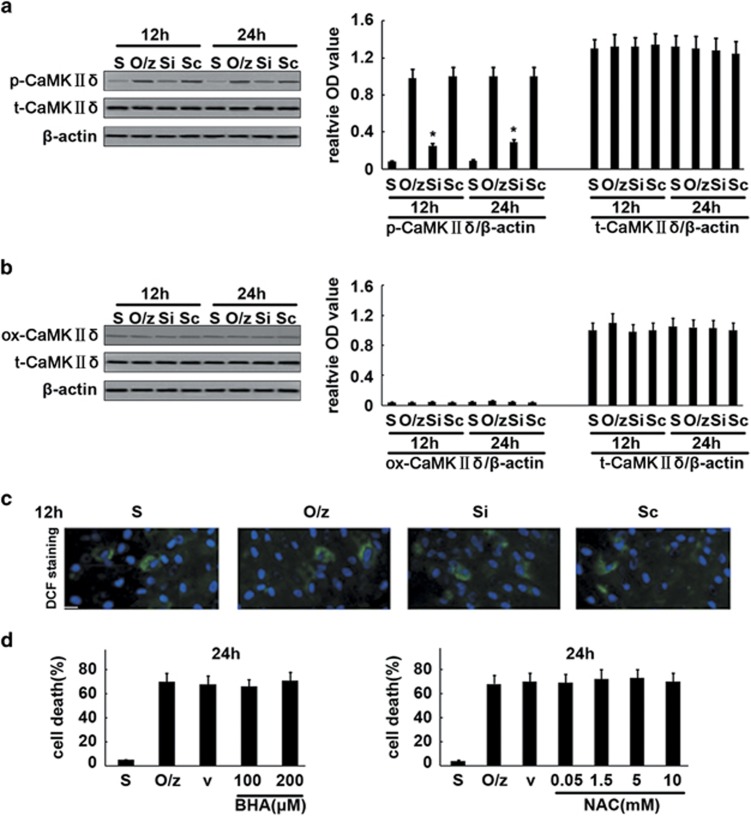
CaMKIIδ is activated via phosphorylation, but not oxidation, in OPCs after OGD/zVAD insult. (a) Representative western blotting images and averaged data indicating phosphorylated and total CaMKIIδ levels in OPCs. Phospho-Thr287 CaMKIIδ levels were increased in OPCs in the OGD/zVAD group 12 and 24 h after OGD, whereas total CaMKIIδ was not affected. Furthermore, RIPK3 inhibition via siRNA decreased phospho-Thr287 CaMKIIδ levels 12 and 24 h after OGD. Data are presented as means ±S.E.M. from three independent experiments. N=6 for each group in each experiment (P<0.05, comparing the siRNA group with the OGD/zVAD group). S: sham; O/z: OGD/zVAD; Si: RIPK3 siRNA; Sc: RIPK3 siRNA scramble. (b) Representative western blotting images and averaged data for oxidation of CaMKIIδ (ox-CaMKII) at M281/282. In the sham control group, CaMKIIδ oxidation is very weak. OGD/zVAD insult did not enhance CaMKIIδ oxidation in OPCs 12 or 24 h after OGD. Data are presented as means±S.E.M of three independent experiments. N=6 for each group in each experiment. S: sham; O/z: OGD/zVAD; Si: RIPK3 siRNA; Sc: RIPK3 siRNA scramble. (c) Representative photomicrographs of ROS production as assessed using DCF staining (green). 4',6-diamidino-2-phenylindole (DAPI) was used as the counterstain in order to highlight the nucleus (blue). ROS production was not increased in OPCs in the OGD/zVAD group 12 h after OGD (scale bar=20 μm). S: sham; O/z: OGD/zVAD; Si: RIPK3 siRNA; Sc: RIPK3 siRNA scramble. (d) OPCs were treated with vehicle, BHA, or NAC at the indicated concentrations together with zVAD 1 h before the OGD insult. Cell death was assessed by measuring the released protease activity in the culture medium. In the presence of these ROS scavengers, OPCs also underwent cell death 24 h after OGD. Data are presented as means±S.E.M. from three independent experiments. N=6 for each group in each experiment. S, sham; O/z, OGD/zVAD; V, vehicle